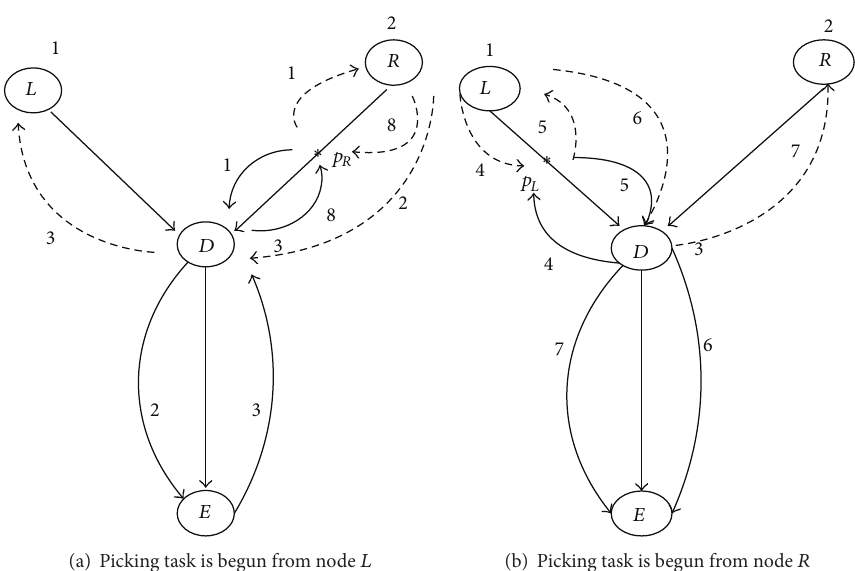
Figure 2: Period-2 orbit of the tree-shaped picking